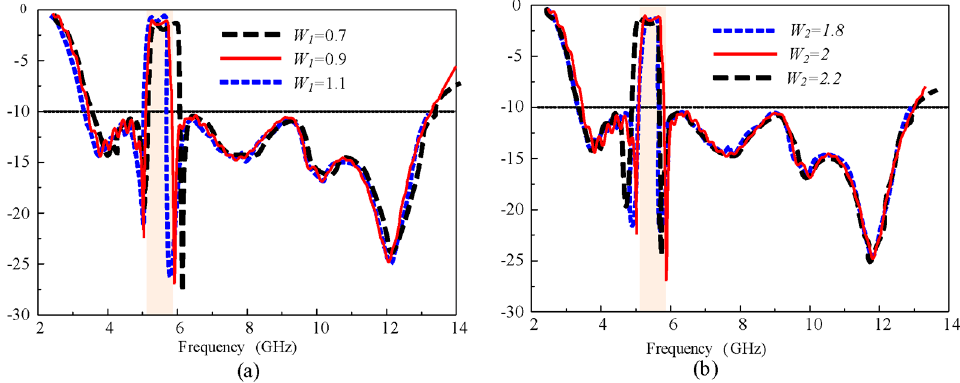
Figure 11. | S 11 | of the antenna for di ff erent widths of ( a ) EBG1 w 1 and ( b ) EBG2 w 2 . Figure 11. |S 11 | of the antenna for different widths of ( a ) EBG1 w 1 and ( b ) EBG2 w 2 .